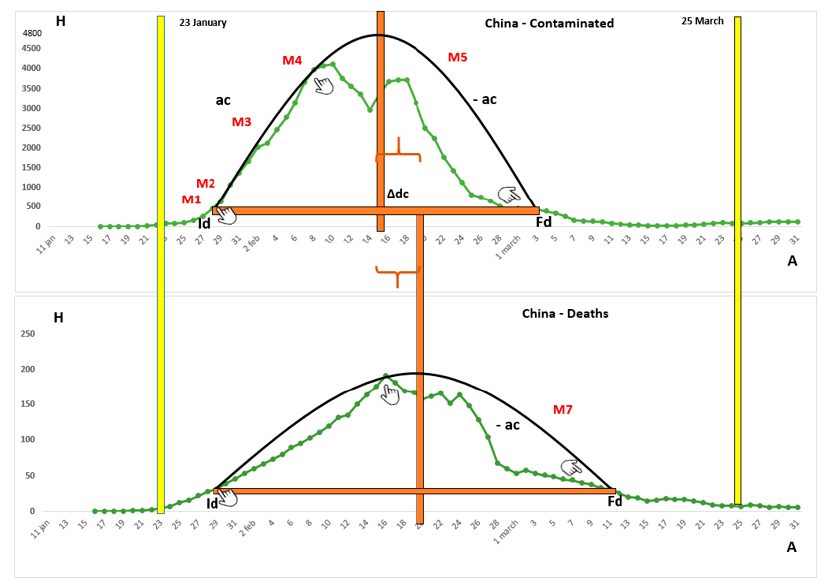
Figure 1. The contaminated people and deaths due to COVID-19 in China. Note. M1, match 1; M2, match 2; M3, match 3; M4, match 4; M5, match 5; M7, match 7; Id, initial date; Fd, final date; ac, acceleration; -ac, deceleration; H, height; A, amplitude; ∆ dc, period between the deaths and contaminated peaks of the ideal curve.